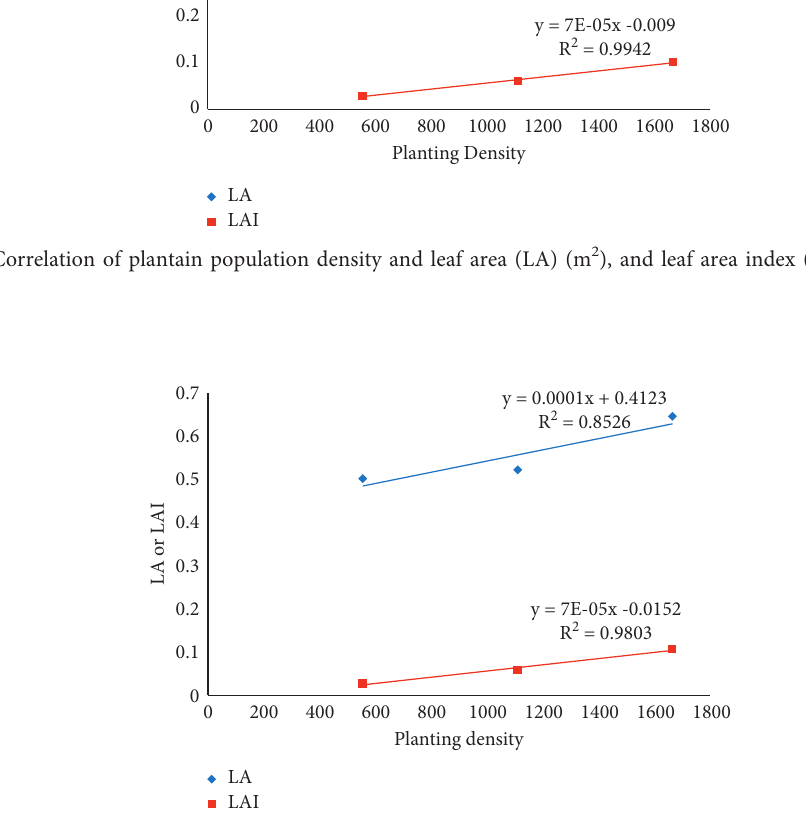
Figure 8: Correlation of plantain population density and leaf area (LA) (m 2 ), and leaf area index (LAI) at Jomoro.